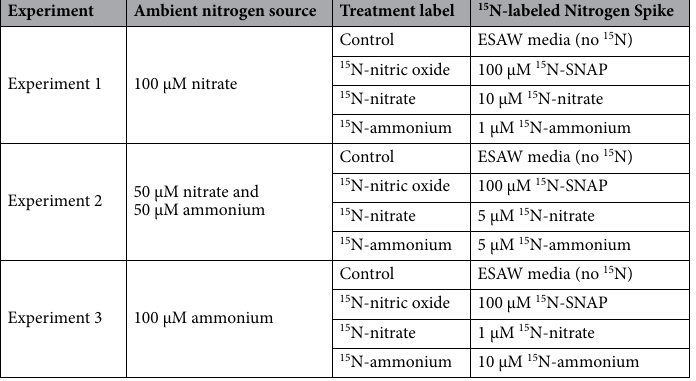
Table 1. Ambient nitrogen source for continuous cultures and 15 N-nitrogen treatment spikes for